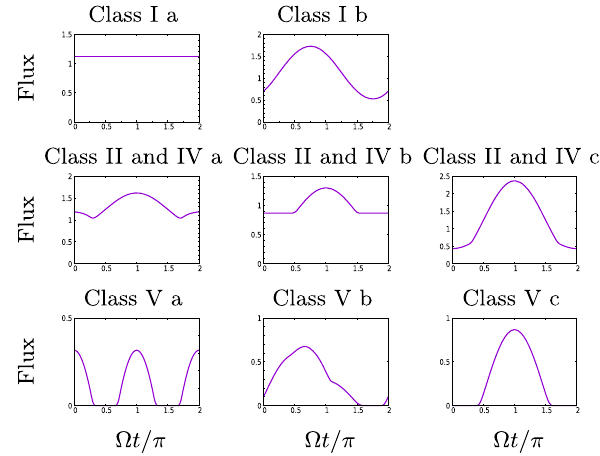
Fig. 24 Representative pulse profiles of each